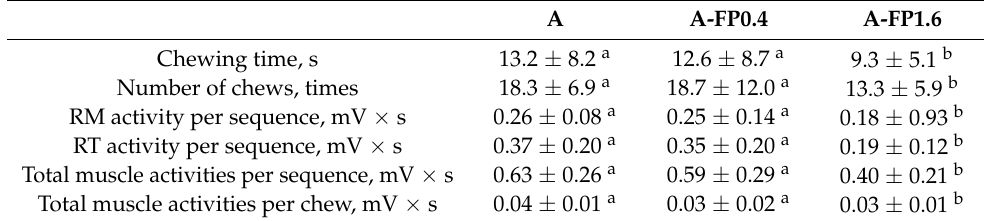
Table 4. Oral processing parameters for chewing of A and A-FP gels.